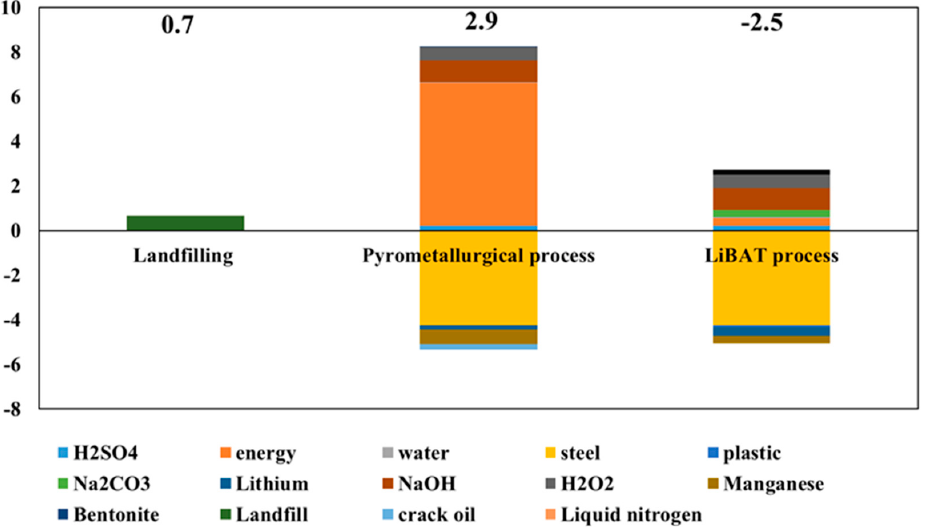
Figure 4. Environmental performance index comparison between landfilling, the LIFE-LIBAT pro- cess and the advanced pyro-metallurgical process, including Li reduction, evaporation and conden-